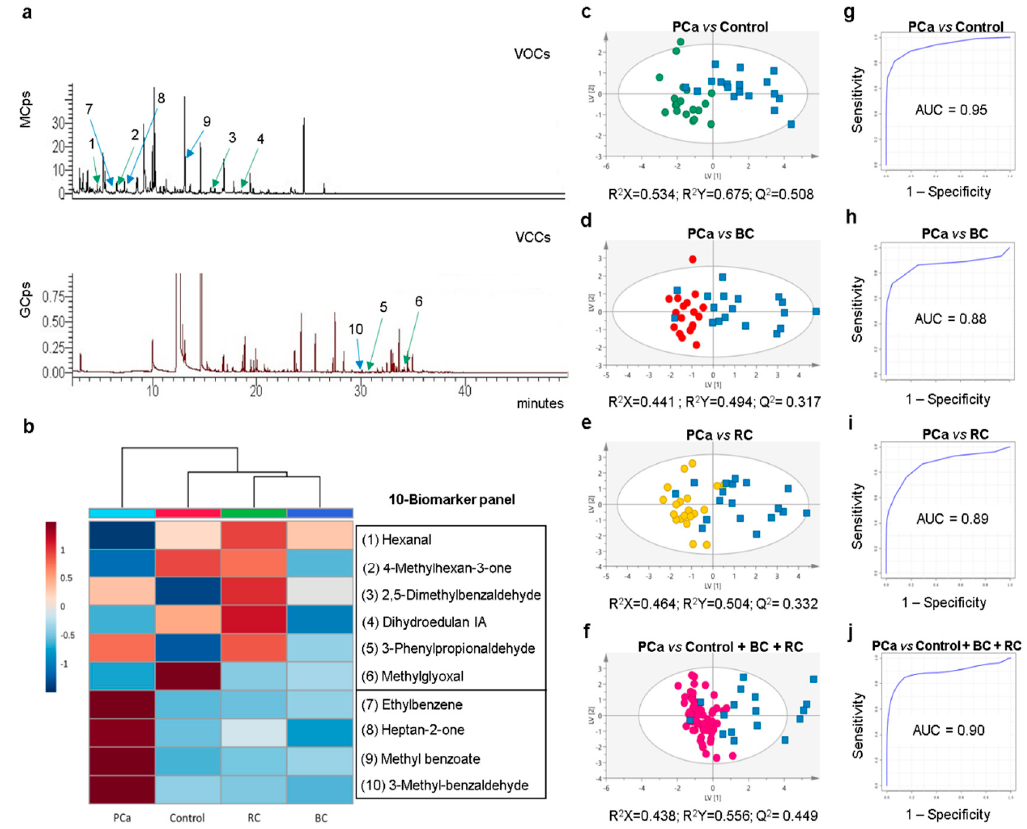
Figure 1. ( a ) Representative GC-MS chromatograms of volatile organic compounds (VOCs) and volatile carbonyl compounds (VCCs) present in urine of prostate cancer (PCa) patients (green arrows indicate the six volatiles (numbers 1–6) in former biomarker panel and blue arrows the surplus four volatiles (numbers 7–10), with the correspondence of numbers to metabolite identities present in (b)). ( b ) Heatmap illustrating the mean levels (normalized peak areas) of metabolites included in the 10-biomarker panel. Rows correspond to the mean normalized peak area of each metabolite with the sample groups in the columns. ( c – f ) Partial least squares discriminant analysis (PLS-DA) scores scatter plots (UV scaling; two components) obtained for the 10-biomarker panel of (c) PCa ( n = 18, blue squares) vs. cancer-free controls ( n = 19, green circles), (d) PCa ( n = 18, blue squares) vs. bladder cancer (BC) ( n = 18, red circles), (e) PCa ( n = 18, blue squares) vs. renal cancer (RC) ( n = 20, yellow circles), (f) PCa ( n = 17, blue squares) vs. cancer-free controls plus BC and RC ( n = 58, pink circles). ( g – j ) Assessment of the diagnostic performance of the PLS-DA models obtained for the 10-biomarker panel of (g) PCa vs. cancer-free controls (area under the curve (AUC) = 0.95; sensitivity = 78%; specificity = 100%; accuracy = 89%), (h) PCa vs. BC (AUC = 0.88; sensitivity = 72%; specificity = 100%; accuracy = 86%), (i) PCa vs. RC (AUC = 0.89; sensitivity = 72%; specificity = 90%; accuracy = 82%), (j) PCa vs. cancer-free controls plus BC and RC (AUC = 0.90; sensitivity = 76%; specificity = 97%; accuracy = 92%).